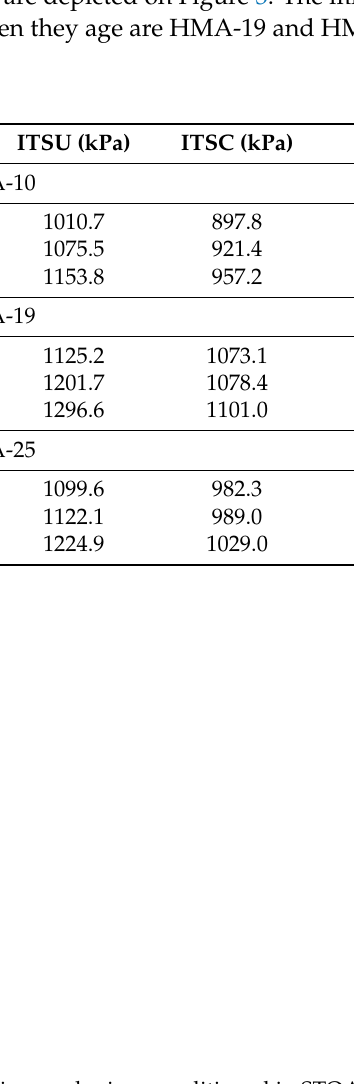
Figure 3. Relationship of ITSU values of control mixes and mixes conditioned in STOA and LTOA.